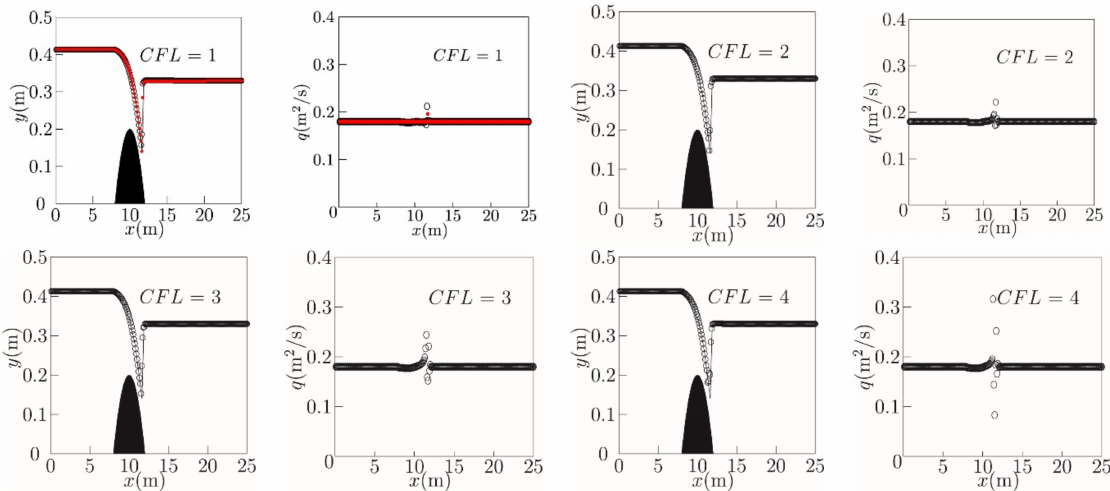
Figure 9. Analytical solution [24] (thin solid line), well-balanced scheme [22] (red circles), and LTS predictions using Algorithm 2 (open circles) of steady-state free surface elevation and mass flux distributions along a channel for transcritical flow at a fixed bed